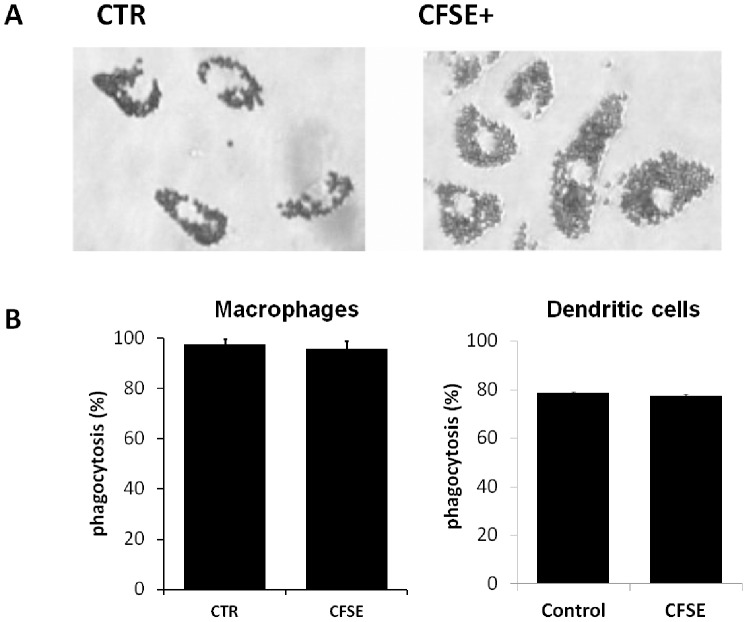
CF.SE-labeling does not alter functionality.The phagocytosis capacity of control and CFSE-labeled BMDM or CFSE-labeled BMDC were similar; 100 cells were counted; the experiment was repeated 3 times; P>0.05.